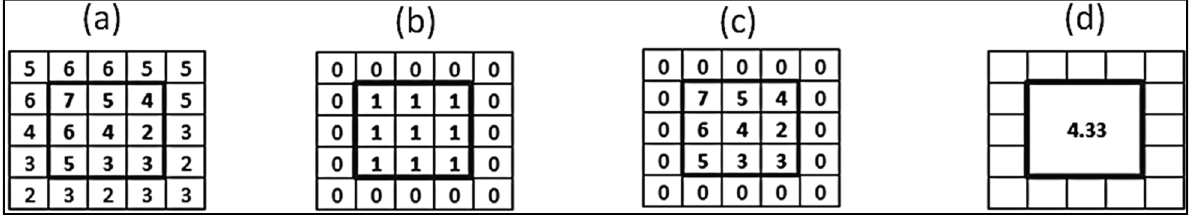
Figure 1. An image segment polygon (bold line) overlaid onto a grid of pixels with intensity values ( a ); the weights assigned to the pixels within the polygon ( b ); new values calculated by multiplying the pixel intensity values by their weights ( c ); the mean segment intensity value ( d ); calculated by dividing the sum of the values in (c) by the sum of the weights in